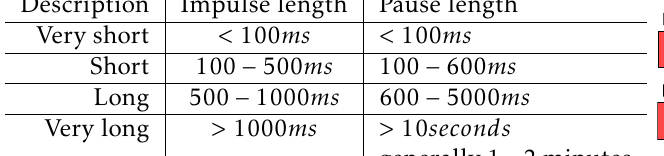
Table 1. Vibration impulseand pause lengths users described duringthe study